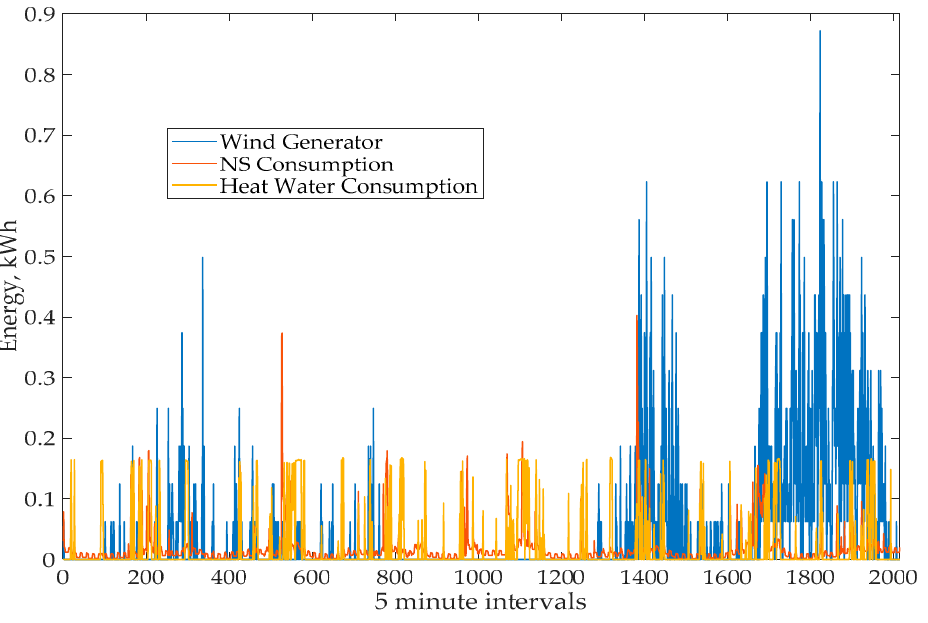
Figure 3. A week sample of initial data from December 2015.